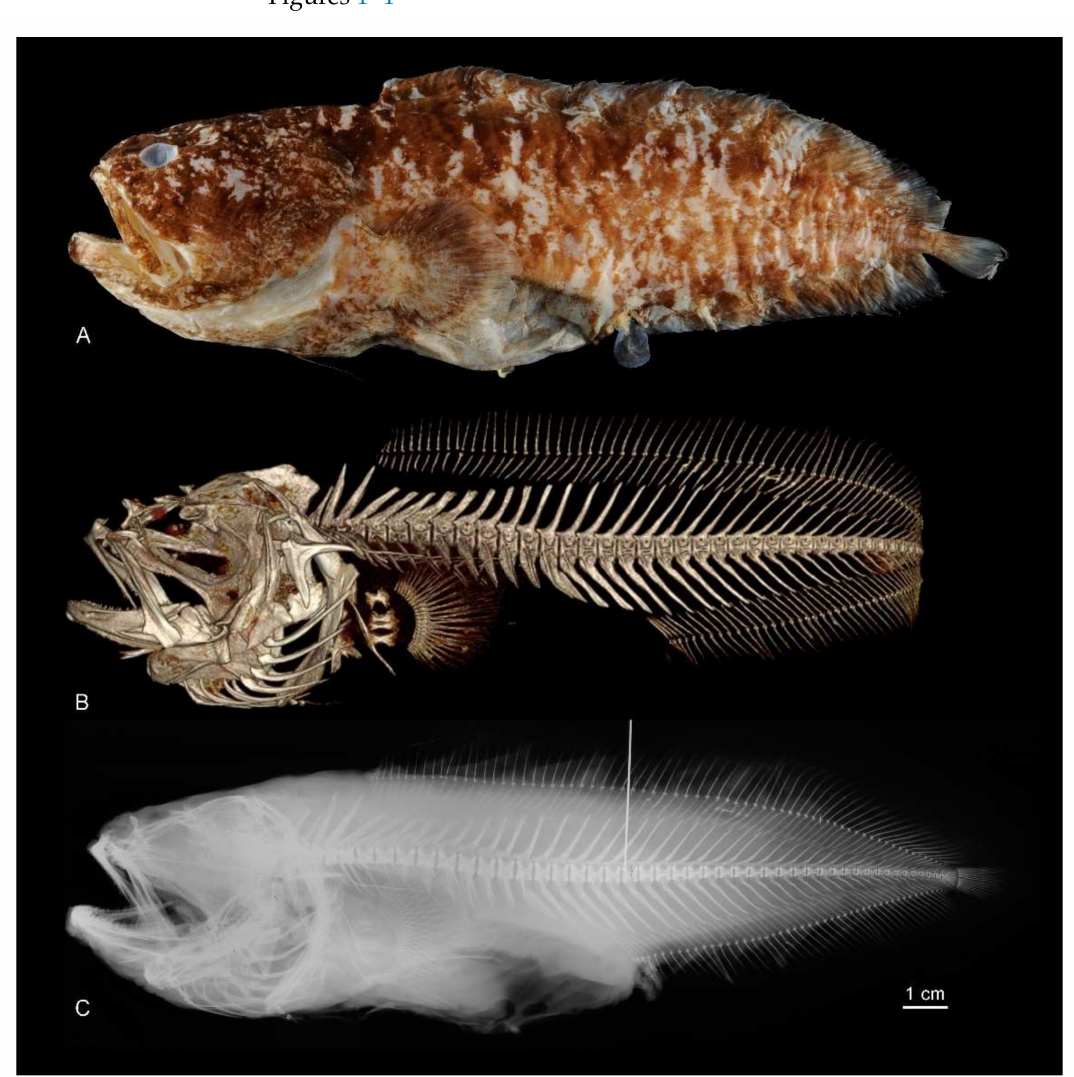
Figure 1. Bidenichthys okamotoi n. sp., holotype ZMUC P239717, ( A ), photograph; ( B ), CT scan; ( C ),